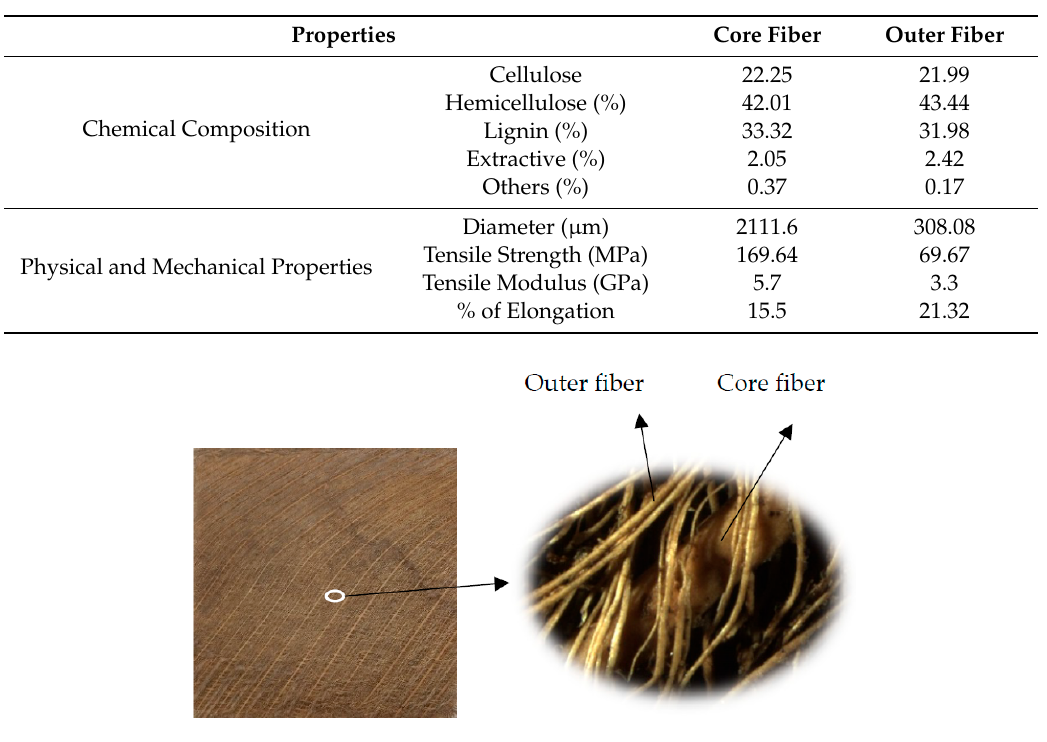
Table 1. The properties of the core and outer fiber of the cocos nucifera sheath [27].